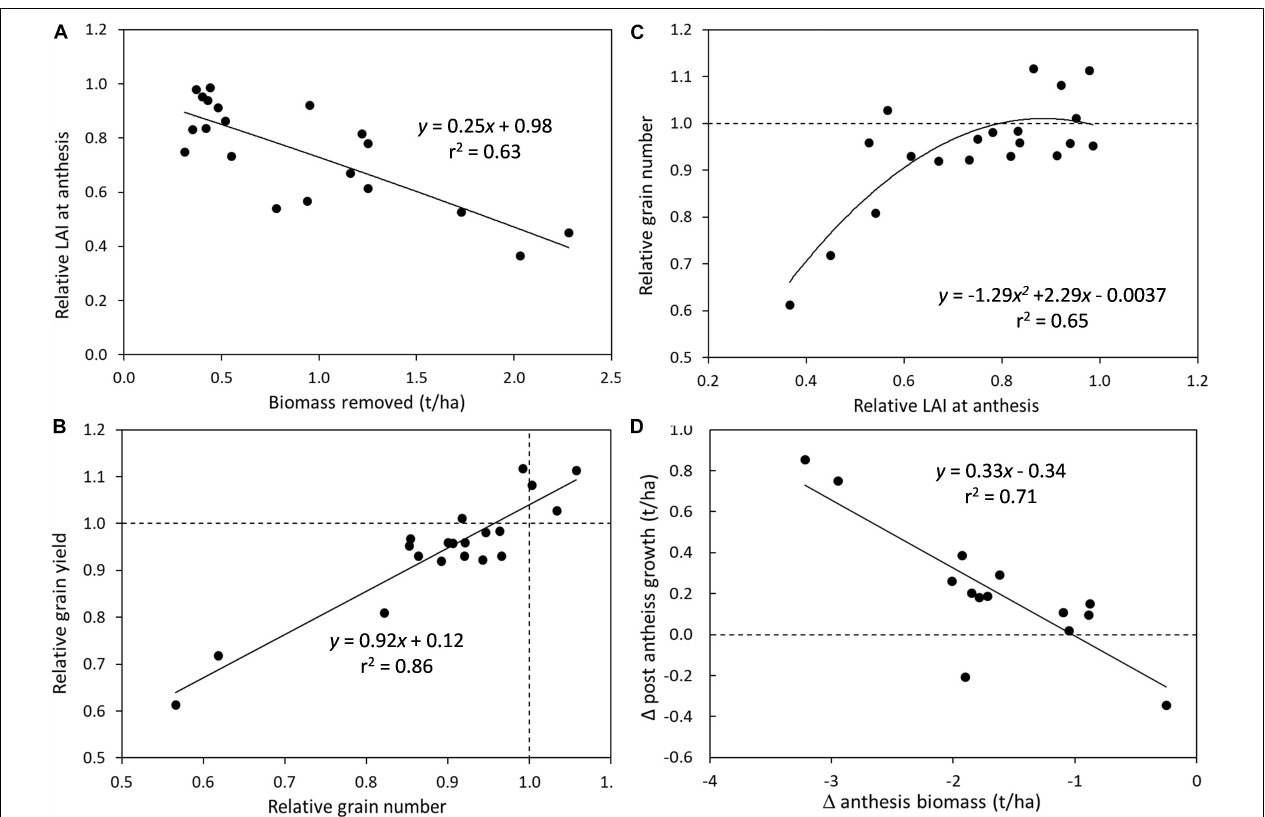
FIGURE 1 | Crop defoliation effects on determinants of grain yield across experiments in spring cereals under water- and nitrogen-unlimited growing conditions: (A) Crop biomass removal effects on the relative leaf area index (LAI) at anthesis (defoliated/undefoliated); (B) Relationship between relative grain number and relative grain yield (defoliated/undefoliated); (C) Relative LAI at anthesis impacts on relative grain number (defoliated/undefoliated); and (D) change in anthesis biomass impacts on the change in post-anthesis